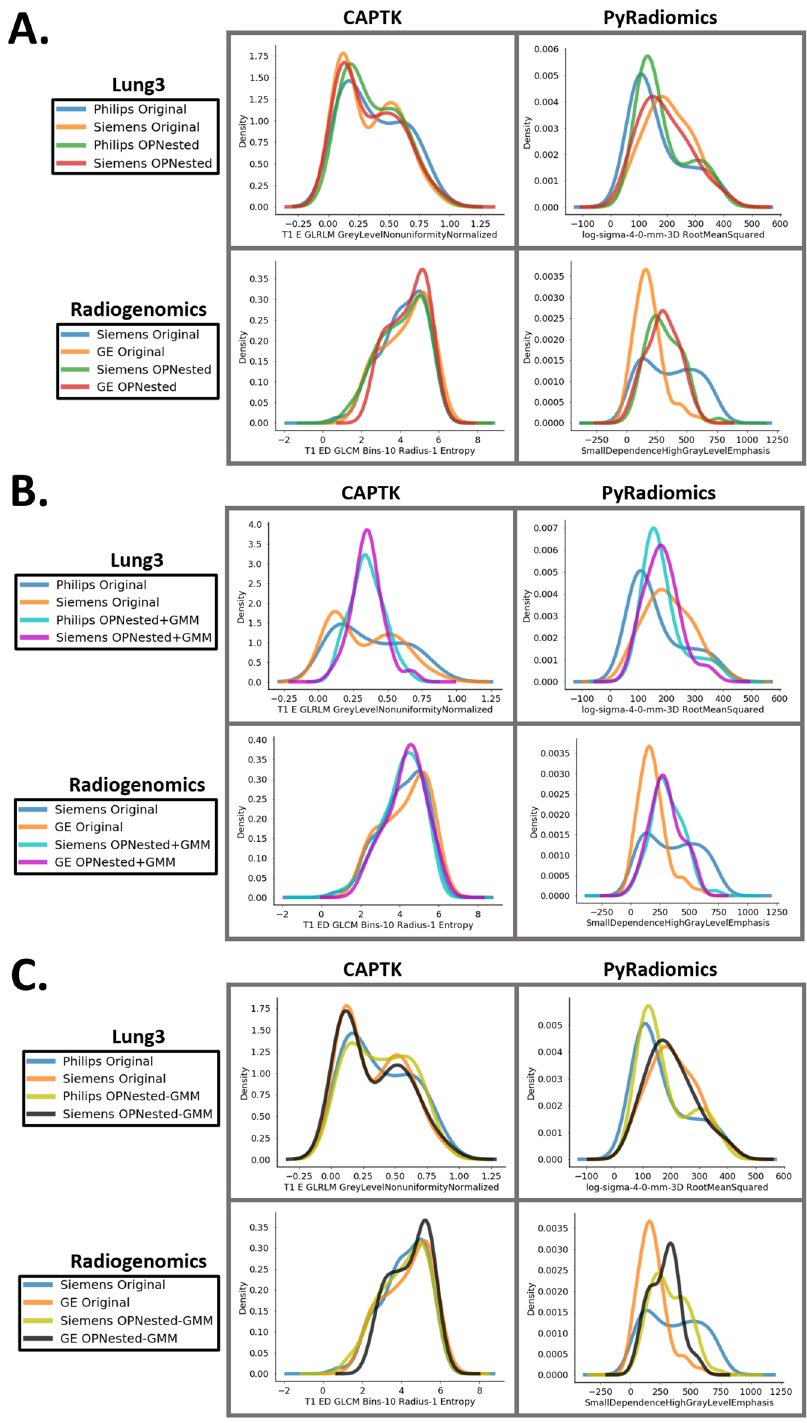
Figure 1. ( A) Representative kernel density plots for the original features and after applying OPNested ComBat. ( B) Representative kernel density plots for the original features and after applying OPNested + GMM ComBat ( C) Representative kernel density plots for the original features and after harmonizing with OPNested − GMM ComBat. Kernel density plots represent ComBat results separated by the batch variable manufacturer, and plots for representative features whose distributions best visually demonstrate the effects of GMM ComBat were selected by screening all the feature distributions before and after harmonization. Harmonization should result in more similar feature